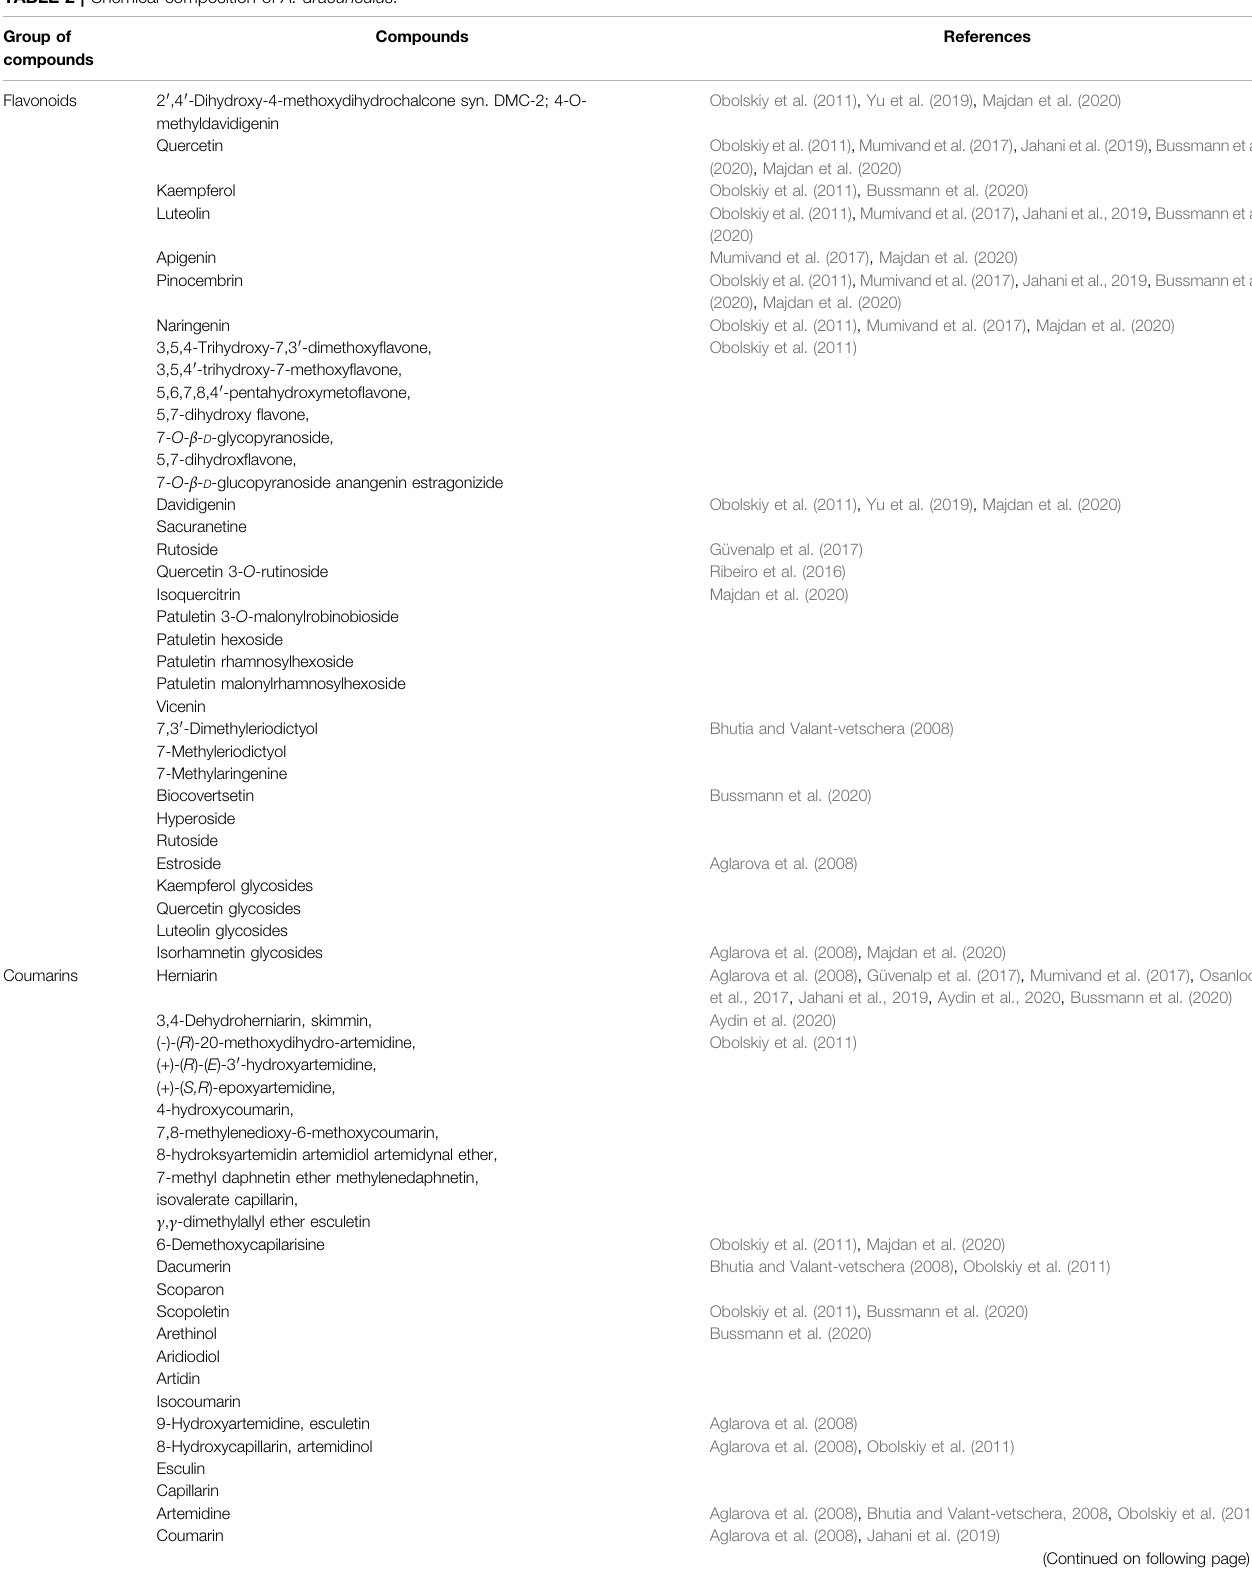
TABLE 2 | Chemical composition of A. dracunculus. Group of